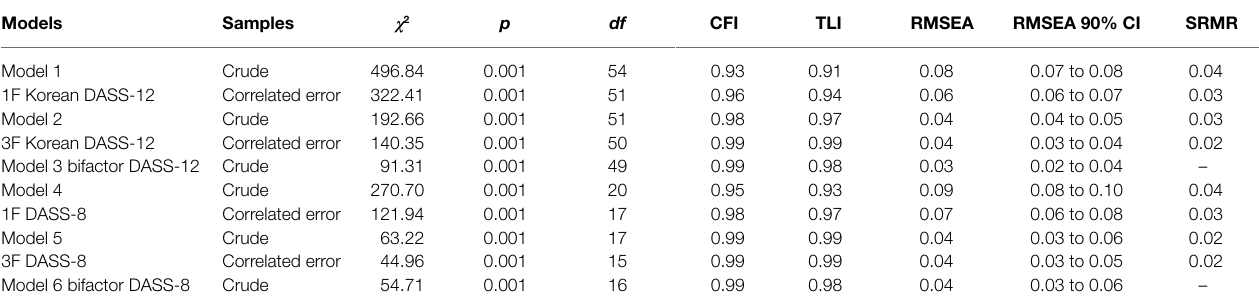
TABLE 1 | Goodness-of-fit of the confirmatory factor analysis models representing the Depression Anxiety Stress Scale-8 (DASS-8) and the DASS-12 in the whole sample. Models